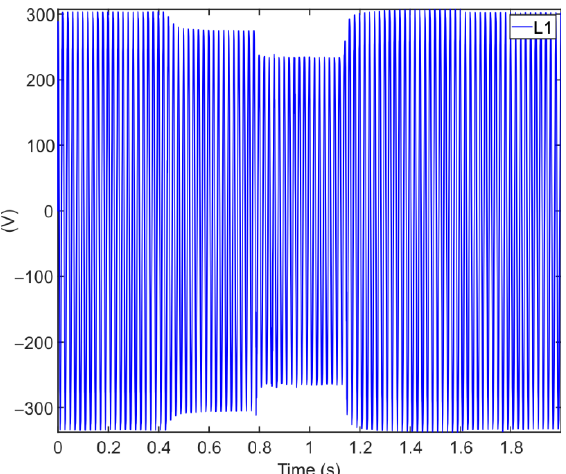
Figure 3. Waveform with voltage variations: 0–0.4 s voltage drop 2.4%; 0.4–0.8 s voltage dip 12%; 0.8–1.2 s voltage dip 24%; after 1.2 s voltage drop 2%.